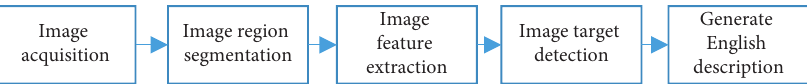
Figure 1: Real-life English scenario translation target